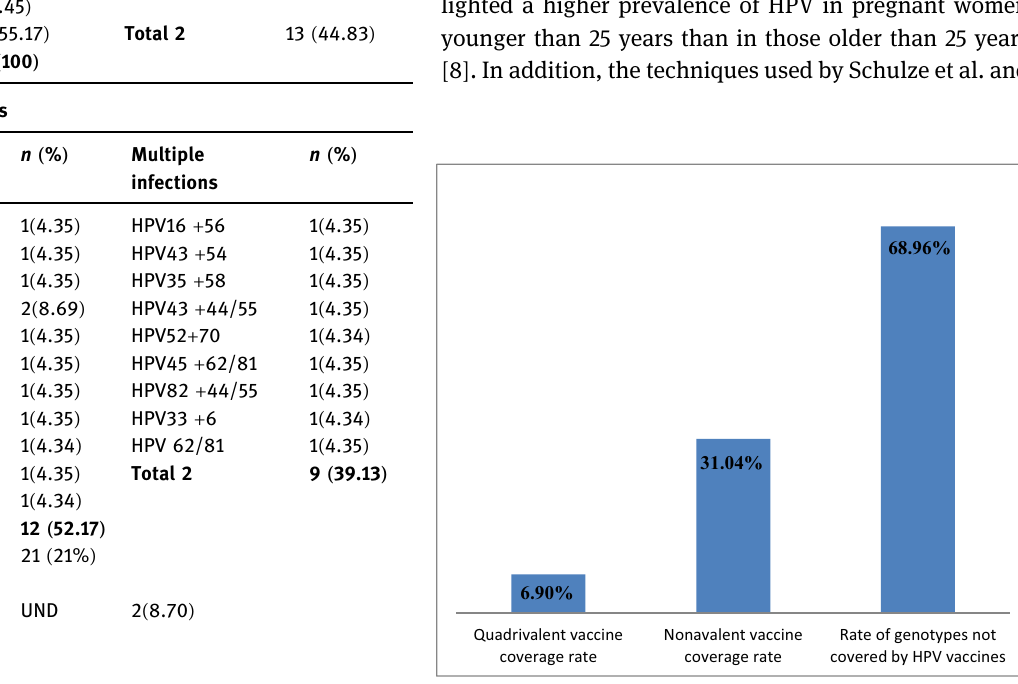
Figure 1: HPV vaccination coverage rate according to genotypes found in pregnant